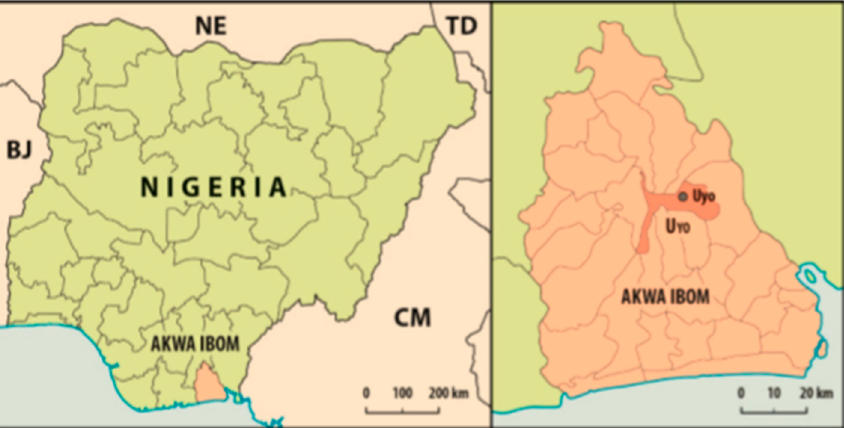
Figure 1. Map of Nigeria showing Akwa Ibom State, and map of Akwa Ibom State showing Uyo. Source: Essien & Samimi, 2019.